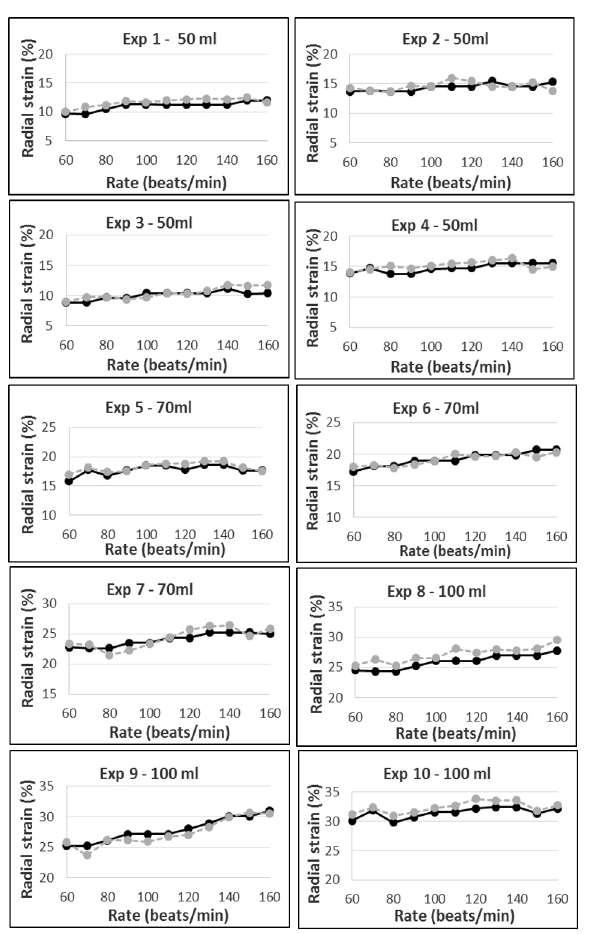
Values are expressed as mean ± SD. Sonomicrometry and echo data were compared using unpaired t-test. NS = non-significant, P > 0.05.